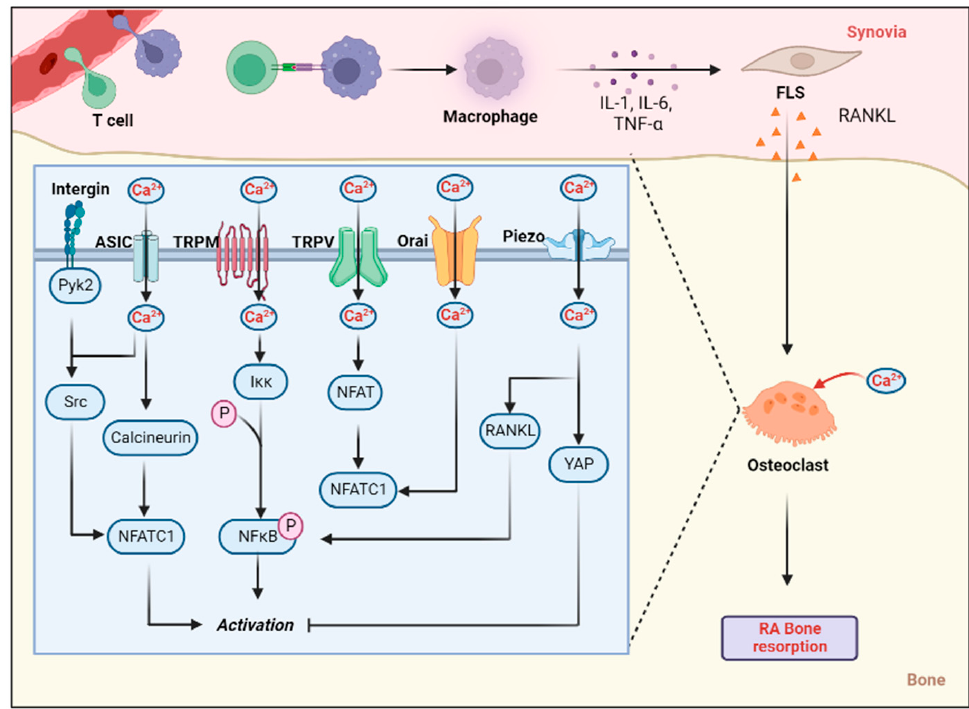
Figure 4. Role of calcium-permeable channel in bone resorption. Synovitis-activated FLS cells can release a number of factors, such as RANKL, leading to an influx of osteoclast calcium ions in the bone. Through signal transmission, this eventually leads to the proliferation and activation of osteoclasts, which intensifies bone resorption (created with